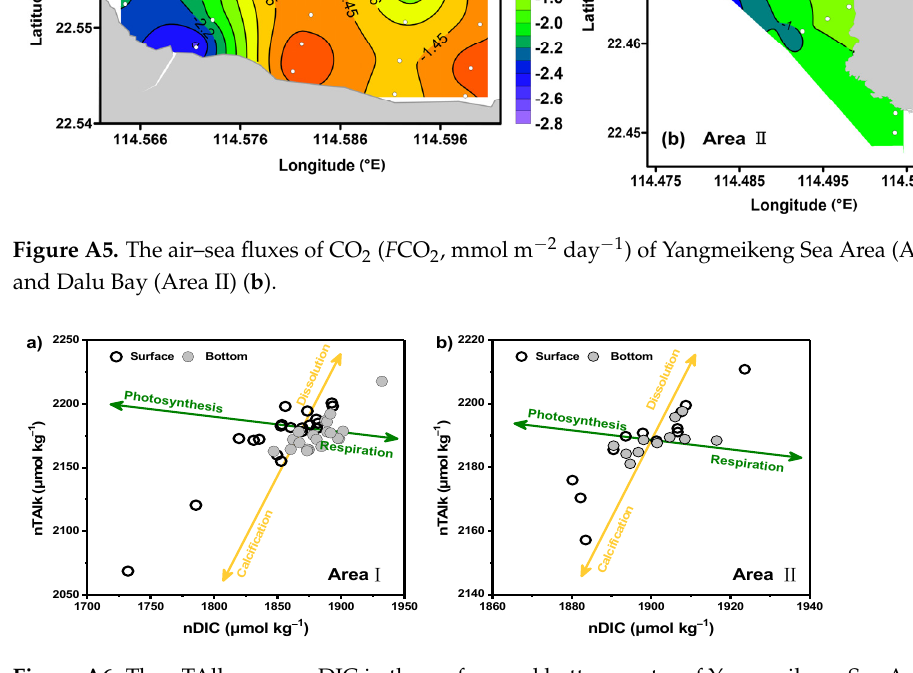
Area Ⅰ : y = -13.7 x + 1900, R 2 = 0.57, p < 0.001 Figure A7. The correlation of carbonate parameters with Chl a ( a – d ) in the surface and bottom water of Yangmeikeng Sea Area (Area I) and Dalu Bay (Area Ⅱ ). Figure A8. The contribution of photosynthesis, microbial respiration, coral metabolism and air–sea exchange to inorganic carbon dynamics ( a – e ) of the reef area of Yangmeikeng Sea Area (Area I) and Dalu Bay (Area Ⅱ ) in the in November. Surface (Area Ⅰ ) Bottom (Area Ⅰ ) Surface (Area Ⅱ ) Bottom (Area Ⅱ )Surface (Area Ⅰ ) Bottom (Area Ⅰ ) Surface (Area Ⅱ ) Bottom (Area Ⅱ )